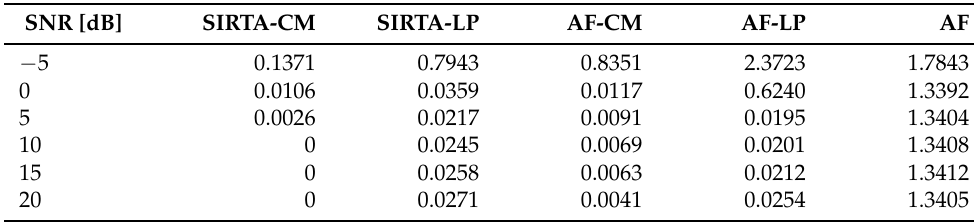
Table 3. NRMSE for the second